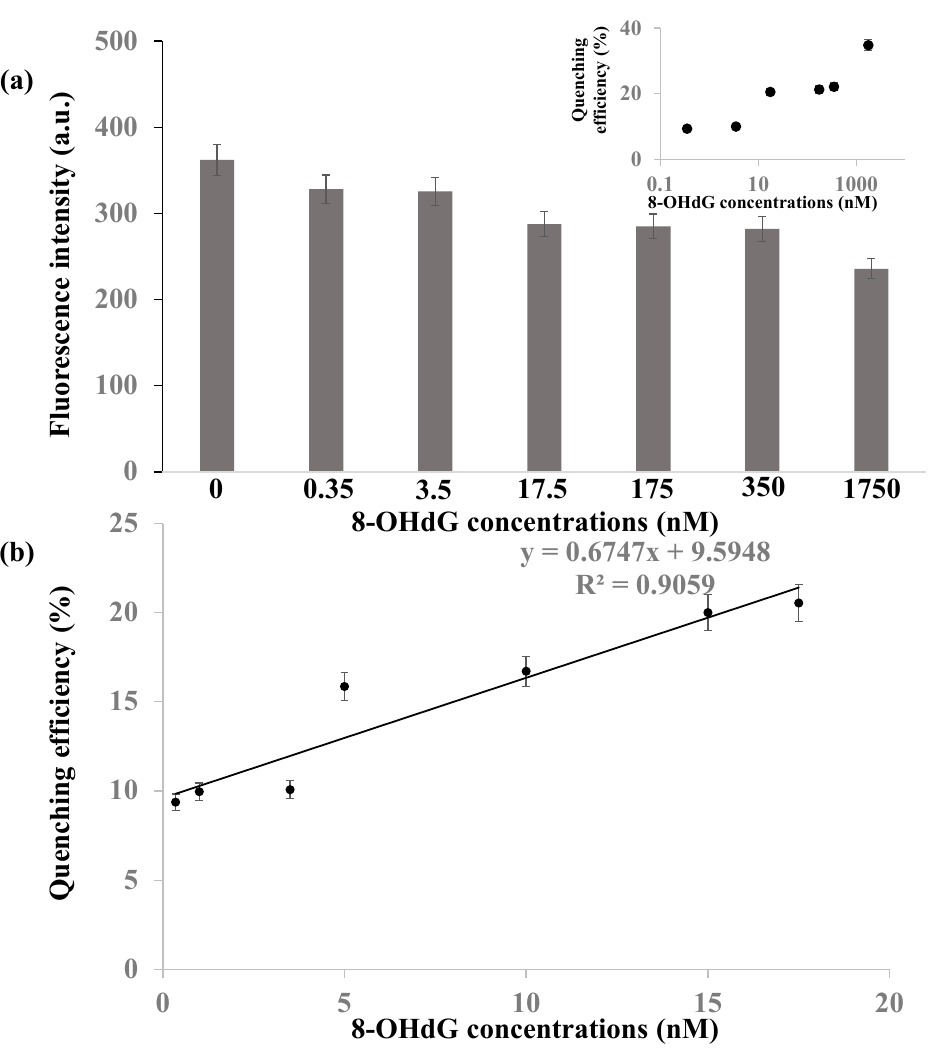
Figure 4. ( a ) Fluorescence intensity change for di ff erent concentrations of 8-OHdG detection